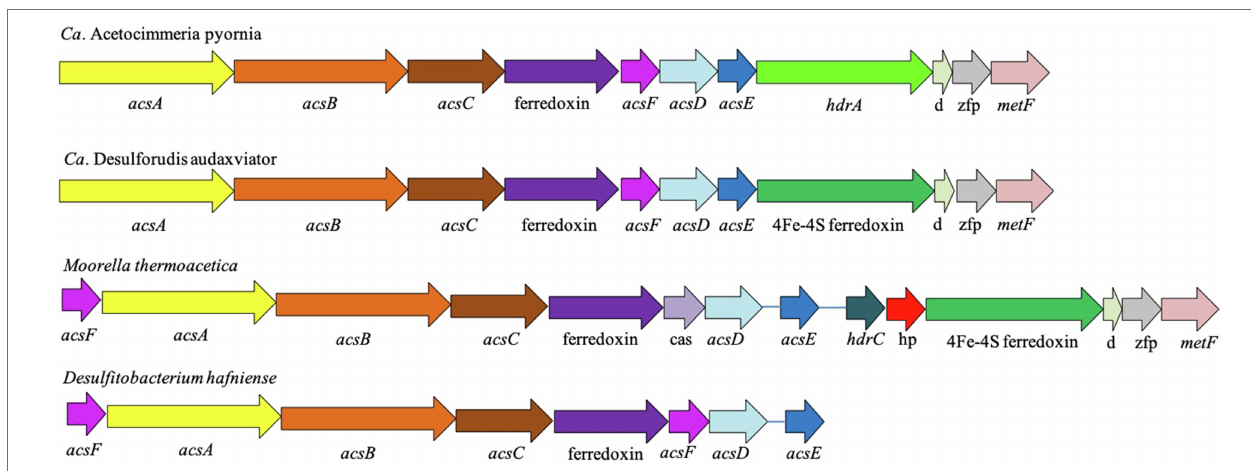
FIGURE 3 | Arrangement of acs gene cluster of the Wood–Ljungdahl pathway on contig-65_203 of Ca. Acetocimmeria pyornia as compared to closely related acetogens. Descriptions of abbreviated gene IDs and relevant Enzyme Commission (EC) numbers (in brackets) are: acsA/cooS , acetyl-CoA synthase alpha subunit/ carbon-monoxide dehydrogenase catalytic subunit [EC:1.2.7.4]; acsB , acetyl-CoA synthase beta subunit [EC:2.3.1.169]; acsC/cdhE , acetyl-CoA decarbonylase/ synthase complex subunit gamma [EC:2.1.1.245]; ferredoxin (RefSeq), no KEGG orthology (KO) assigned; acsF/cooC , CO dehydrogenase maturation factor; cas, cobyrinic acid a,c-diamide synthase (RefSeq), no KO assigned; acsD/cdhD , acetyl-CoA decarbonylase/synthase complex subunit delta [EC:2.1.1.245]; acsE , 5-methyltetrahydrofolate corrinoid/iron sulfur protein methyltransferase [EC:2.1.1.258]; hdrC , heterodisulfide reductase subunit C; hp, hypothetical protein; hdrA , heterodisulfide reductase subunit A [EC:1.8.98.1]; 4Fe-4S ferredoxin (RefSeq), no KO assigned; d , methyl-viologen-reducing hydrogenase subunit delta (RefSeq), no KO assigned; zfp, zinc-finger protein (RefSeq), no KO assigned; and metF , methylenetetrahydrofolate reductase (NADPH)